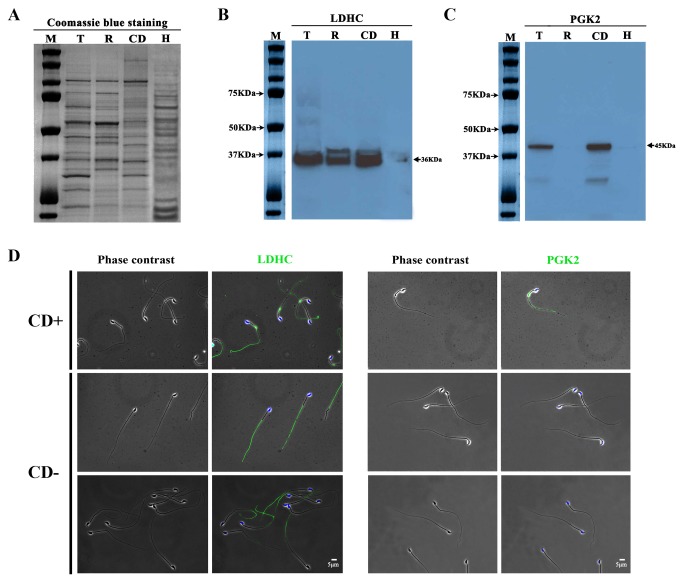
Enrichment of lactate dehydrogenase C (LDHC) and phosphoglycerate kinase (PGK2) in cytoplasmic droplets (CDs) and CD-dependent localization of LDHC and PGK2 in epididymal spermatozoa.(A) A representative SDS-PAGE gel showing equal loading of proteins (8 μg/lane) isolated from total epididymal spermatozoa (T), epididymal spermatozoa after CD removal (R), purified CDs (CD) and heart (H). M, protein size marker. (B) A representative Western blot result showing levels of LDHC in total epididymal spermatozoa (T), epididymal spermatozoa after CD removal (R), purified CDs (CD) and heart (H). (C) A representative Western blot result showing levels of PGK2 in total epididymal spermatozoa (T), epididymal spermatozoa after CD removal (R), purified CDs (CD) and heart (H). (D) Immunofluorescent staining of LDHC and PGK2 in CD-bearing (upper panels), CD-free (middle panels) epididymal spermatozoa form the caput, and epididymal spermatozoa after centrifugation-based CD removal (lower panels). All panels were in the same magnification (Scale bar, 5μm).